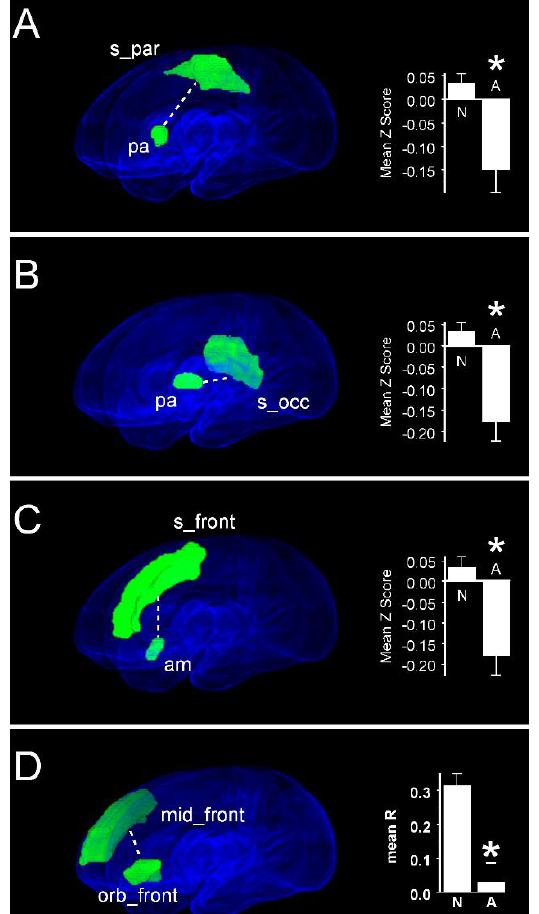
Figure 7. Region pairs exhibiting increased and decreased functional connectivities in infants with normal scores on the cognitive subscale of the Bayley III assessment at two years post-menstrual age compared with infants with scores < 85. Obliquely projected 3D reconstructions of MRI images of cerebral grey matter and identified parcellated regions derived from a neonatal atlas. Dashed white lines depict connectivity relationships. Inset: Fisher-transformed Z-scores ± 1 SEM. ( A ) Pallidum and superior parietal gyrus. ( B ) Pallidum and superior occipital gyrus. ( C ) Amygdala and superior frontal gyrus. (D ) Middle frontal cortex ad orbital frontal cortex. N: Normal; A: Abnormal. * P FDR < 0.05. In contrast to cognitive scores, increased functional connectivity in infants with normal motor scores compared with those having abnormal motor scores were restricted to interactions between the left pallidum and vision-related cortical regions (Figure 8A). Compared with children with abnormal motor scores, infants with normal motor scores demonstrated a greater functional connectivity between the left pallidum and each of the right precuneus (Normal: 0.05 ± 0.03 vs. Abnormal: − 0.14 ± 0.05; P FDR = 0.015), left cuneus (Normal: 0.03 ± 0.03 vs. Abnormal: − 0.14 ± 0.04; P FDR = 0.015), and left calcarine cortex (Normal: 0.04 ± 0.03 vs Abnormal: − 0.13 ± 0.04; P FDR = 0.018). Notably, these motor scores between bilateral primary visual (calcarine) cortices (Normal: 0.62 ± 0.03 vs. Abnormal: 0.83 ± 0.05; P FDR = 0.018, Figure 8B), as well as between the left calcarine and the contralateral cuneus cortex (Normal: 0.36 ± 0.03 vs. Abnormal: 0.59 ± 0.05; P FDR = 0.018, Figure 8C). Finally, we observed no significant di ff erences in functional connectivity when infants with normal and abnormal language scores were